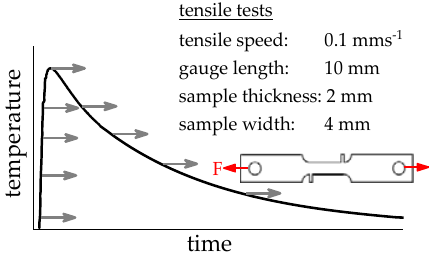
Figure 4. Schematic measurement plan of the thermo-mechanical analysis, with the major parameters of the tensile test. Described in more detail in [15].